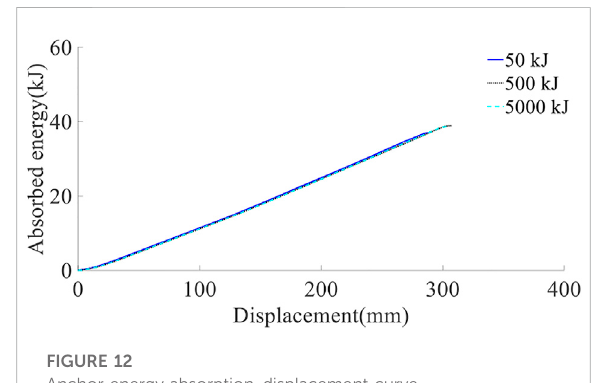
FIGURE 12 Anchor energy absorption-displacement